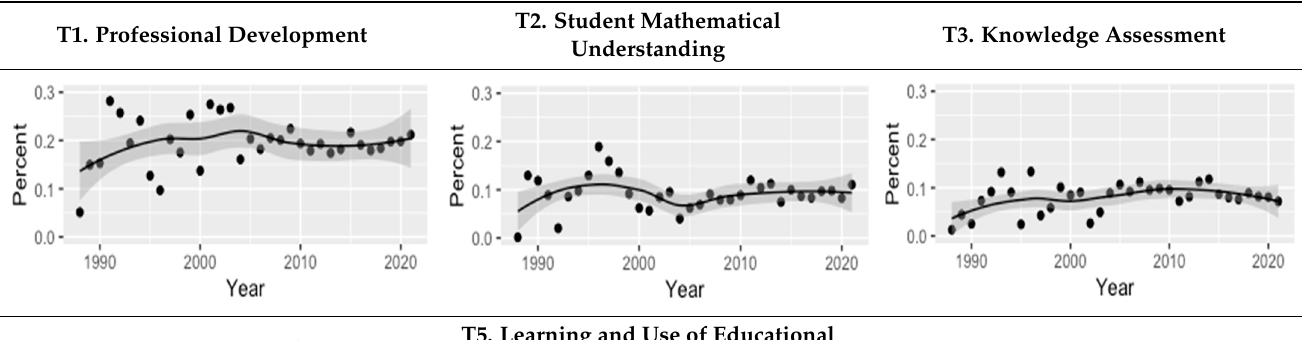
Table 7. Change in topic proportion by year.